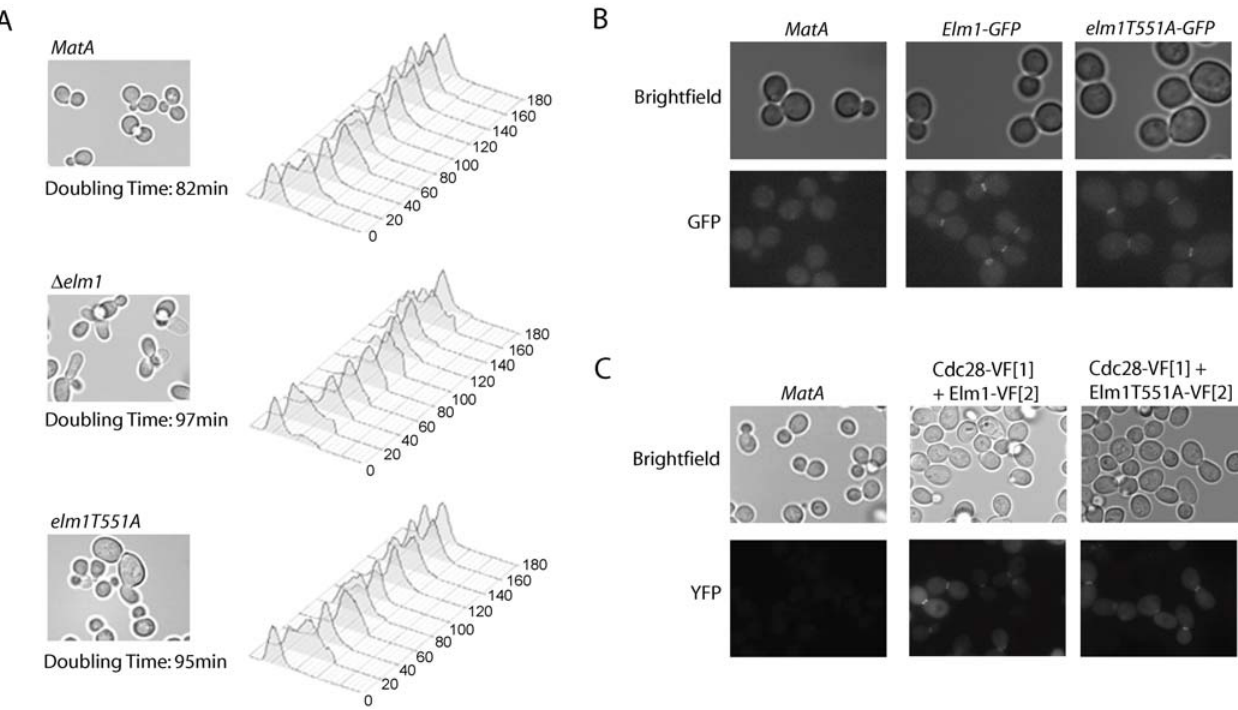
Figure 5. Phenotypic characterization of the Elm1 deletion strain and the elm1T551A mutant strain. (A) Morphology, doubling time and DNA replication of the three strains, MatA , D elm1 , and elm1T551A . (B) Elm1-GFP and elm1T551A-GFP expressed from the endogenous ELM1 promoter localize to the bud neck of dividing yeast cells. (C) Interaction between Cdc28 and both Elm1 and elm1T551A was detected at the bud neck of dividing yeast using yEmVenus PCA.